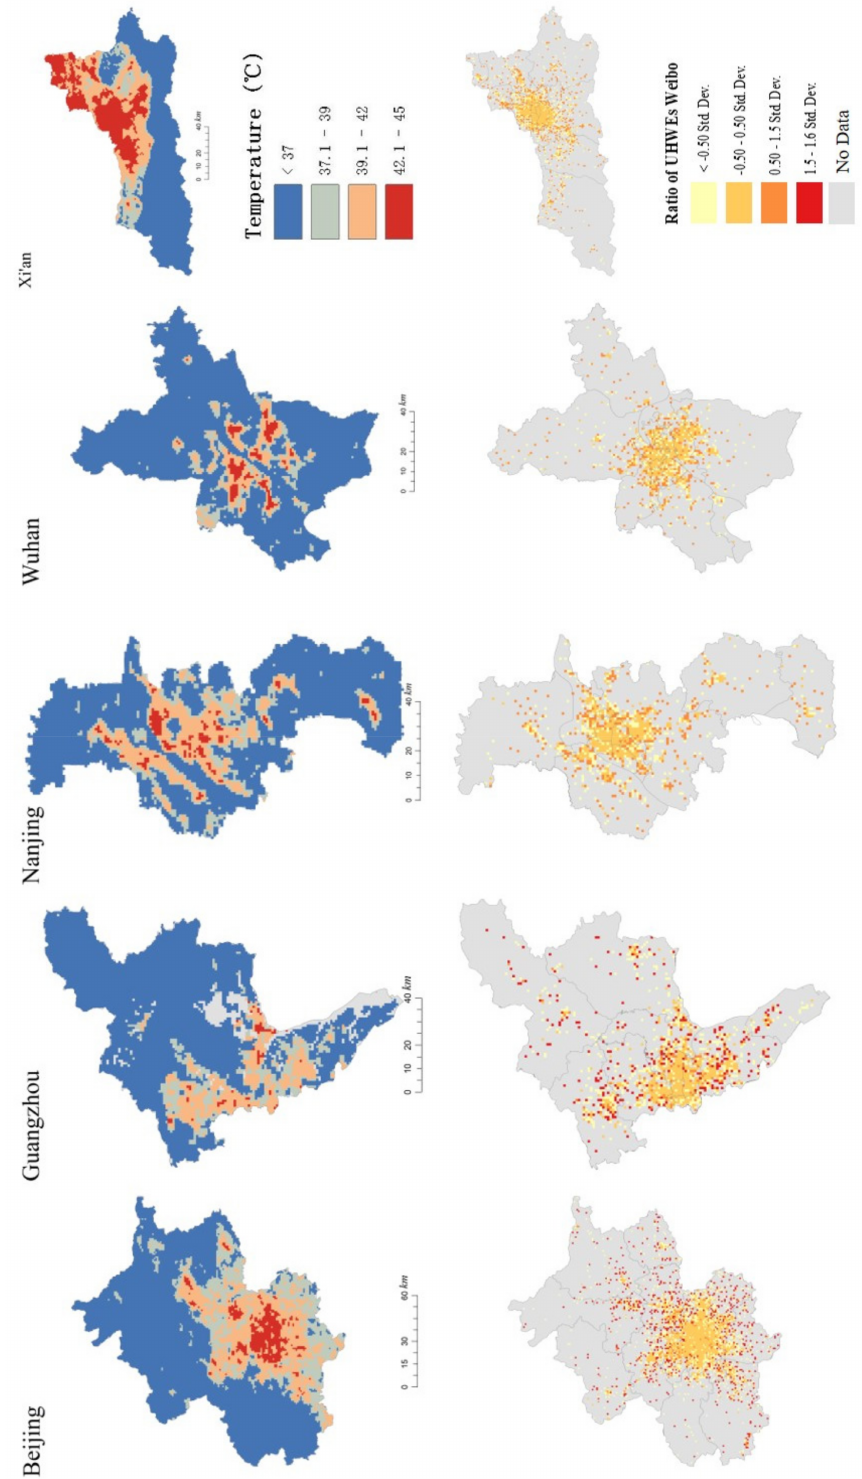
Figure 4. Spatial patterns of residential sensitivity to HWEs between geographic space with LST ( left ) and on Weibo ( right